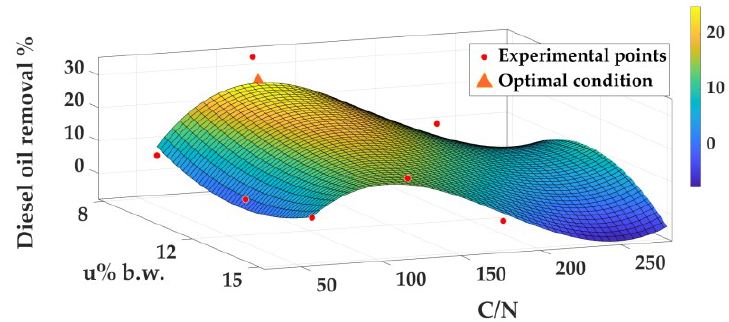
Figure 12. Response surface for diesel oil removal efficiency at t = 35 days.